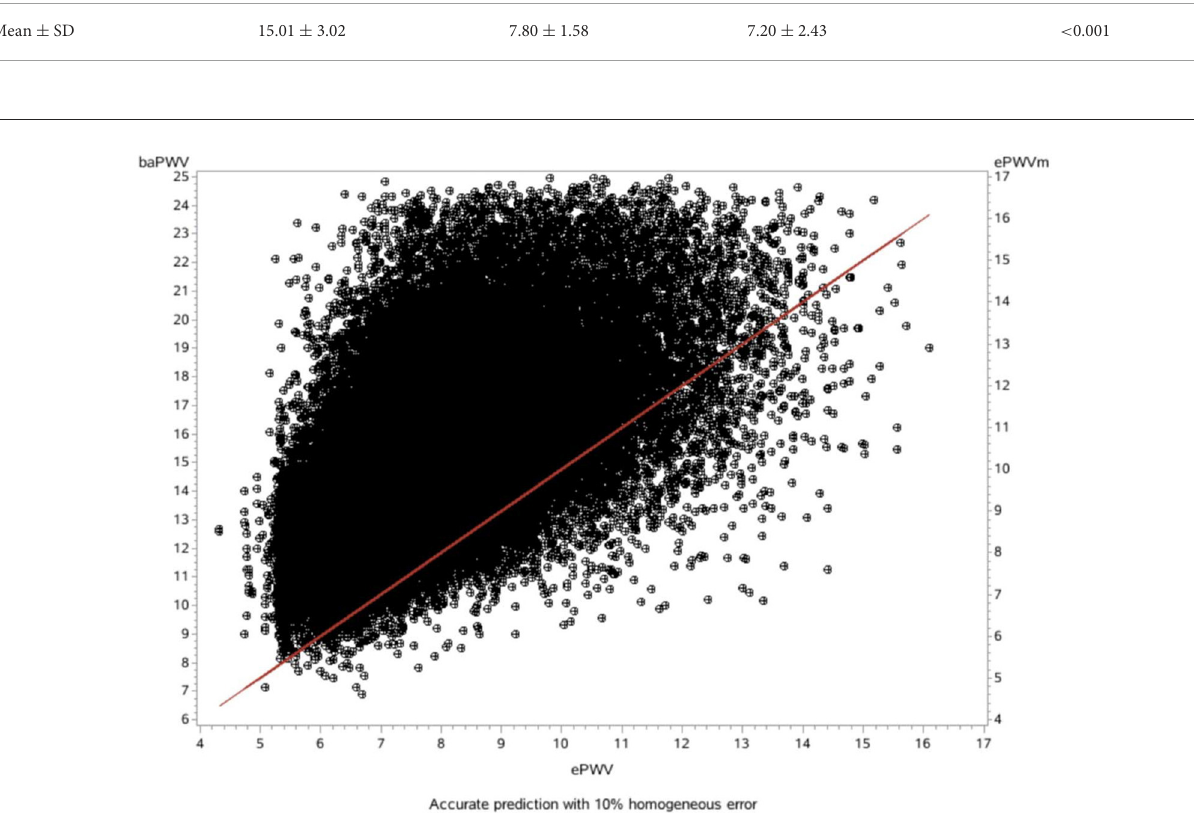
FIGURE1 Scatter diagram showing the relationship between the baPWV and the ePWV (slope: 1.18, R 2 :